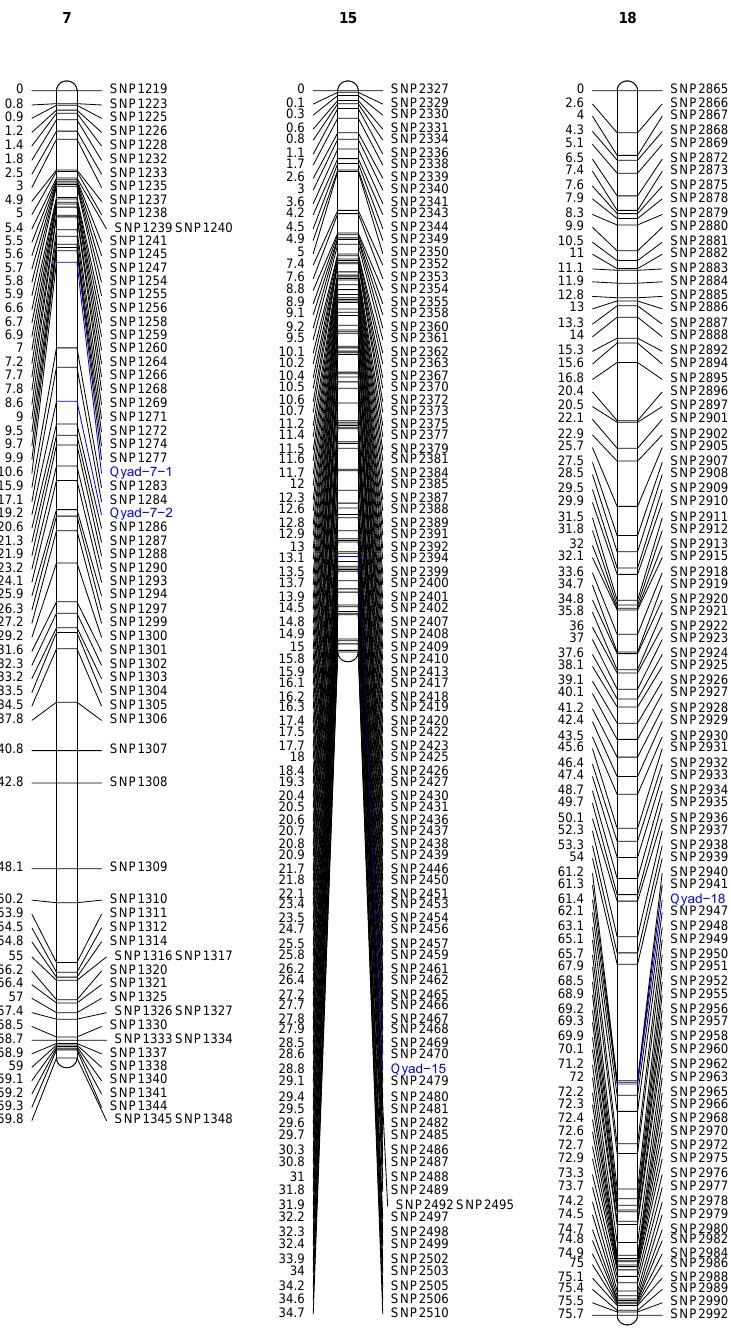
Figure 2. Genetic map of water yam showing significant QTLs associated with yam anthracnose disease resistance. Only those chromosomes where significant QTL are located are displayed. The identified QTLs are highlighted in blue on each chromosome.